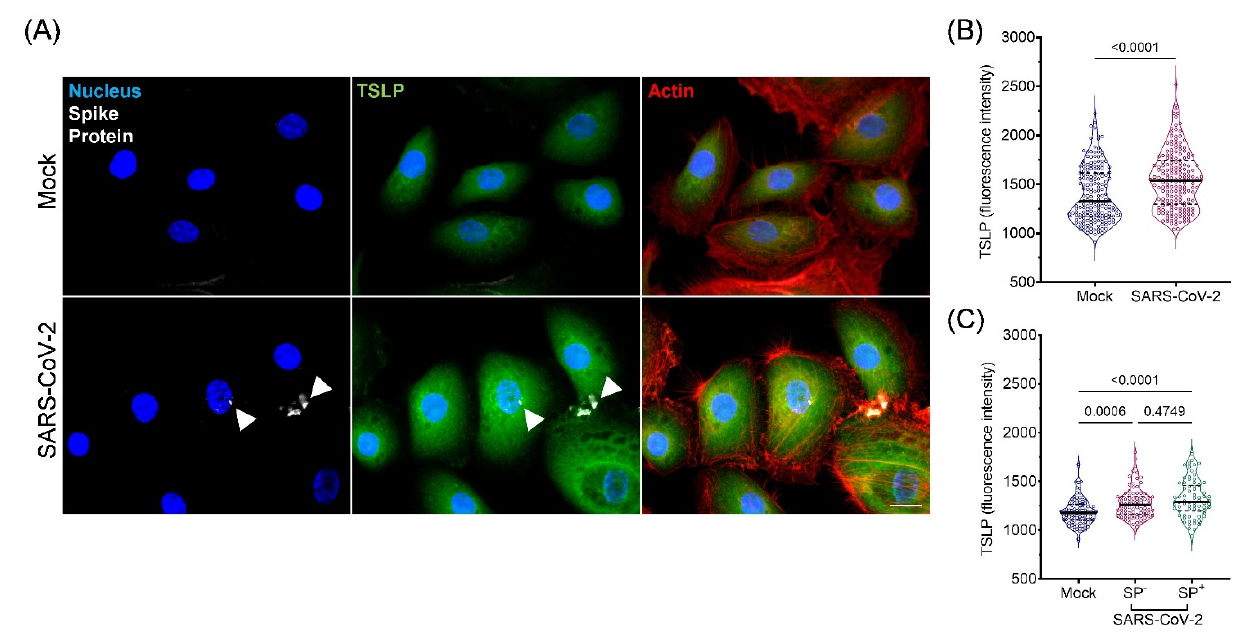
Figure 5. Infection of patient-derived bronchial brushings with SARS-CoV-2. ( A ) Bronchial brushings were collected from an individual donor, grown in culture, and subjected to mock infection (upper panel) or infected with SARS-CoV-2 virus (MOI 1) for 24 h (lower panel). Cells were fixed, permeabilized, and labeled for TSLP (green), SARS-CoV-2 SP (white), nucleus (blue), and actin cytoskeleton (red). Arrowheads indicate SP immunofluorescence in punctate regions. ( B ) Volocity software analysis of intracellular TSLP fluorescence intensity in mock and SARS-CoV-2-infected cells ( n = 358 for Mock, n = 324 for SARS-CoV-2-infected cells). ( C ) Fluorescence intensity of TSLP in mock- and SARS-CoV-2-infected SP − cells compared with SARS-CoV-2 infected SP + cells ( n = 90 for mock, n = 86 for SARS-CoV-2 SP − , n = 72 for SARS-CoV-2 SP + ). Results from all donors ( n = 3) are shown in ( B ) and from a representative donor in ( C ). Data are presented as individual cells (dots), median (solid line), interquartile range (dotted line), and kernel density (violin). Mann–Whitney and Kruskal–Wallis were used to compare fluorescence in ( B , C ), respectively. Scale bar represents 10 μ m.